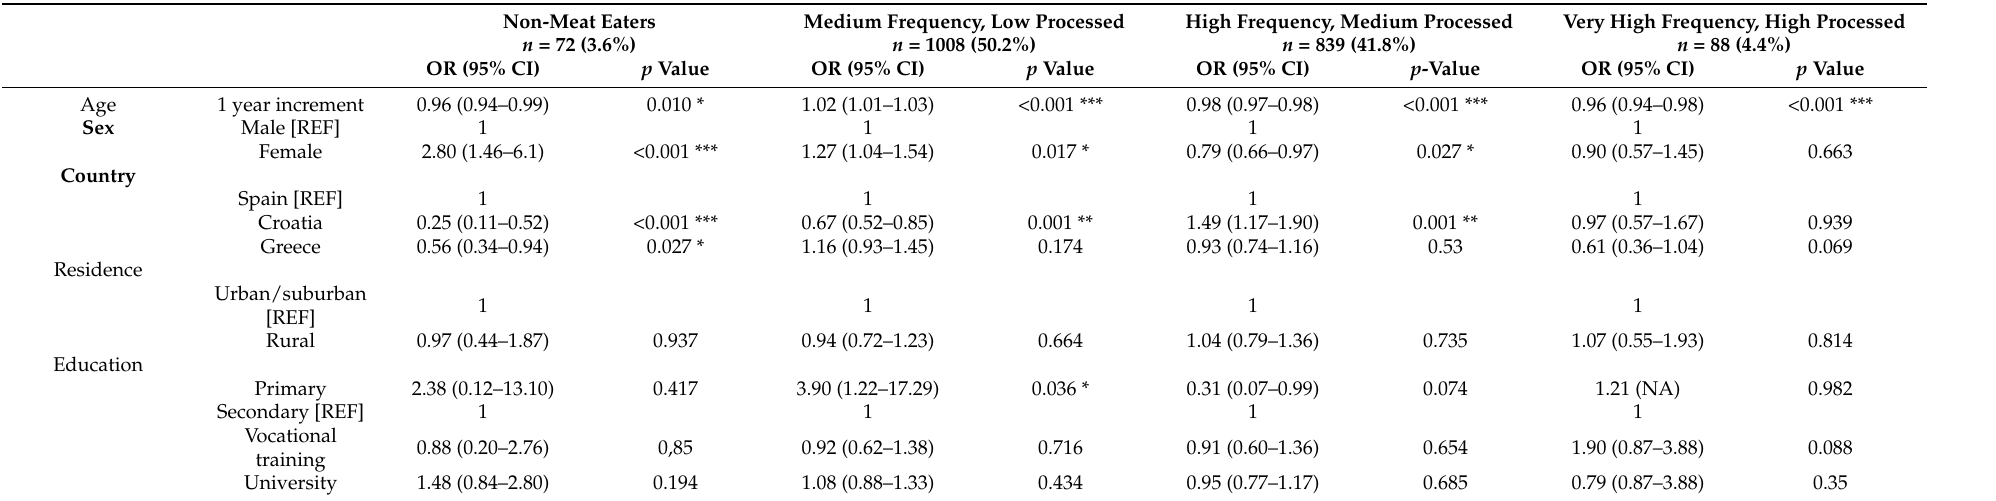
Table 2. Sociodemographic characteristics; logistic regression